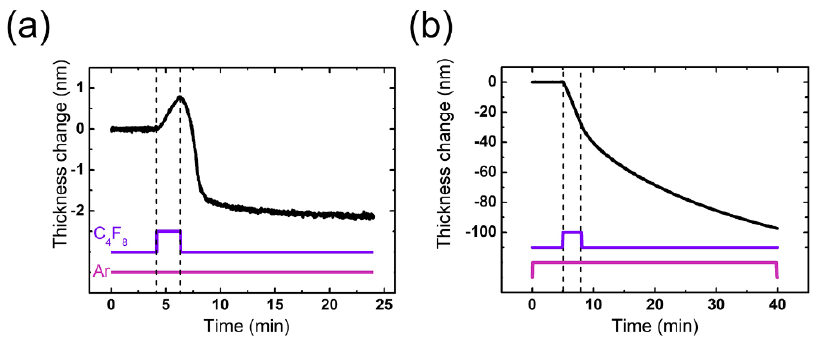
Figure 2. Thickness change in SiO 2 during one cycle of ALE at ( a ) 100 W and ( b ) 300 W.